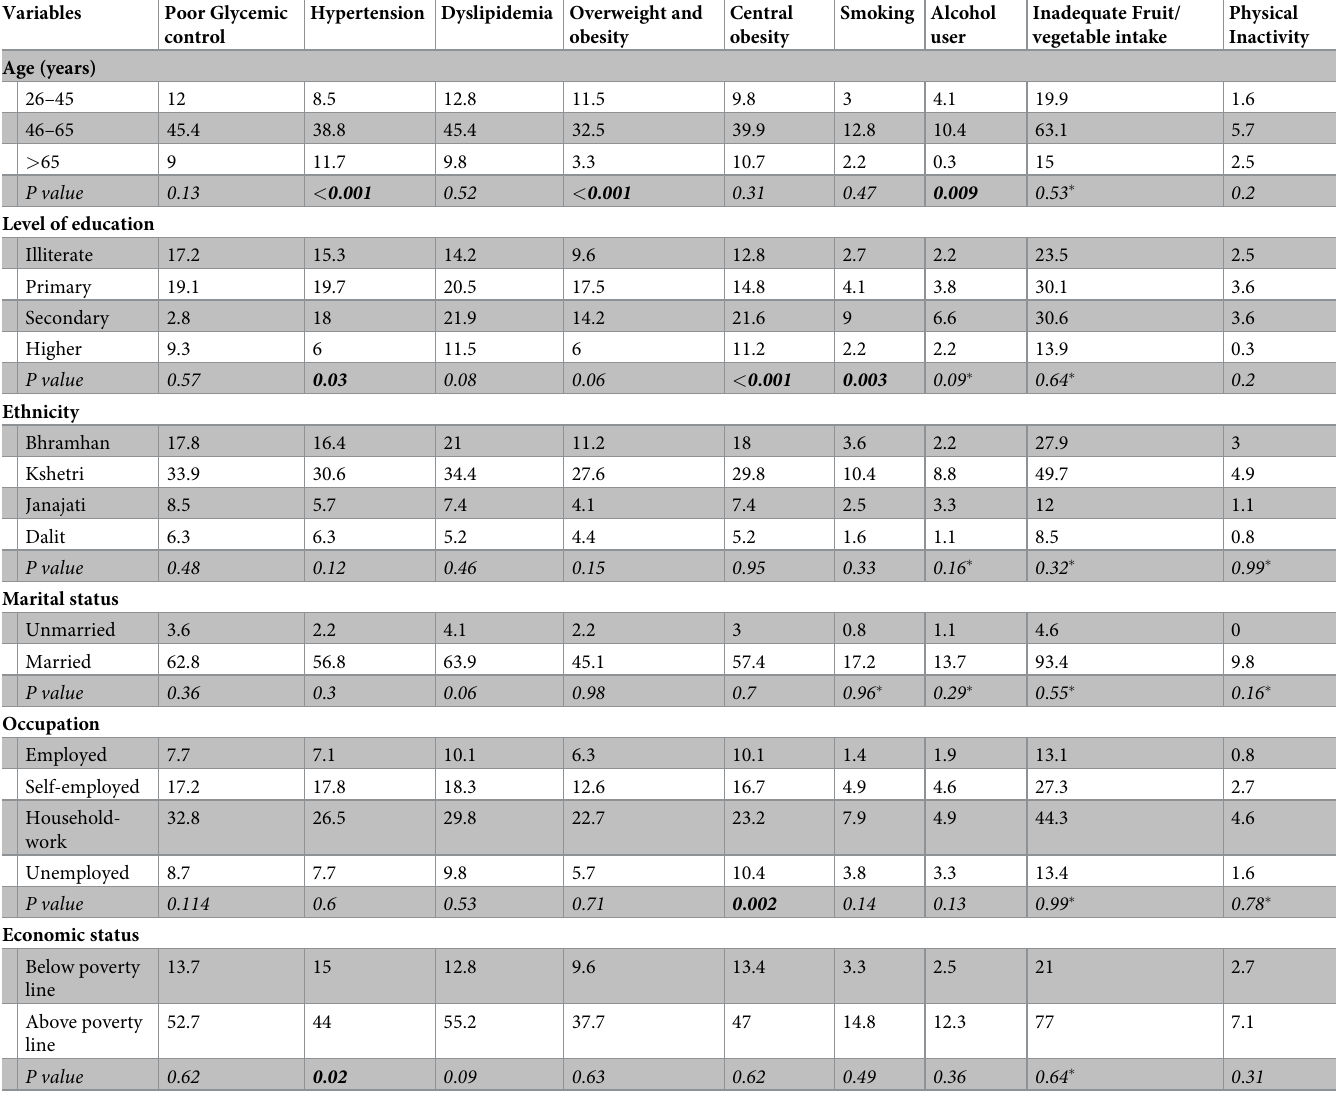
Table 4. Distribution of poor glycemic control and CVD risk factors among study participants stratified by age and socio-economic characteristics. Variables Poor Glycemic